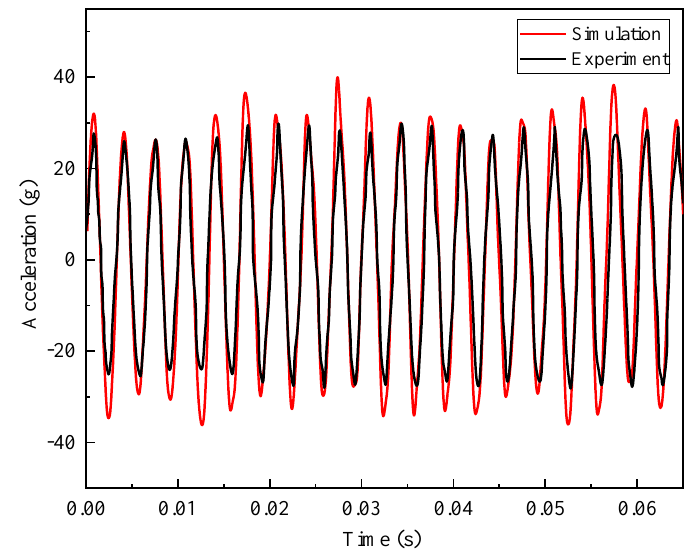
Figure 13. Comparison of acceleration at excitation position.